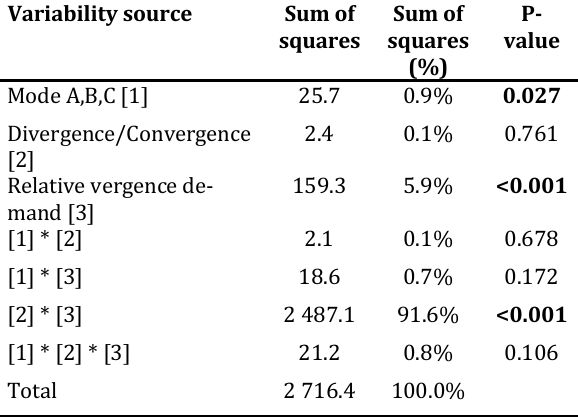
Table 1. Repeated measures ANOVA based on full